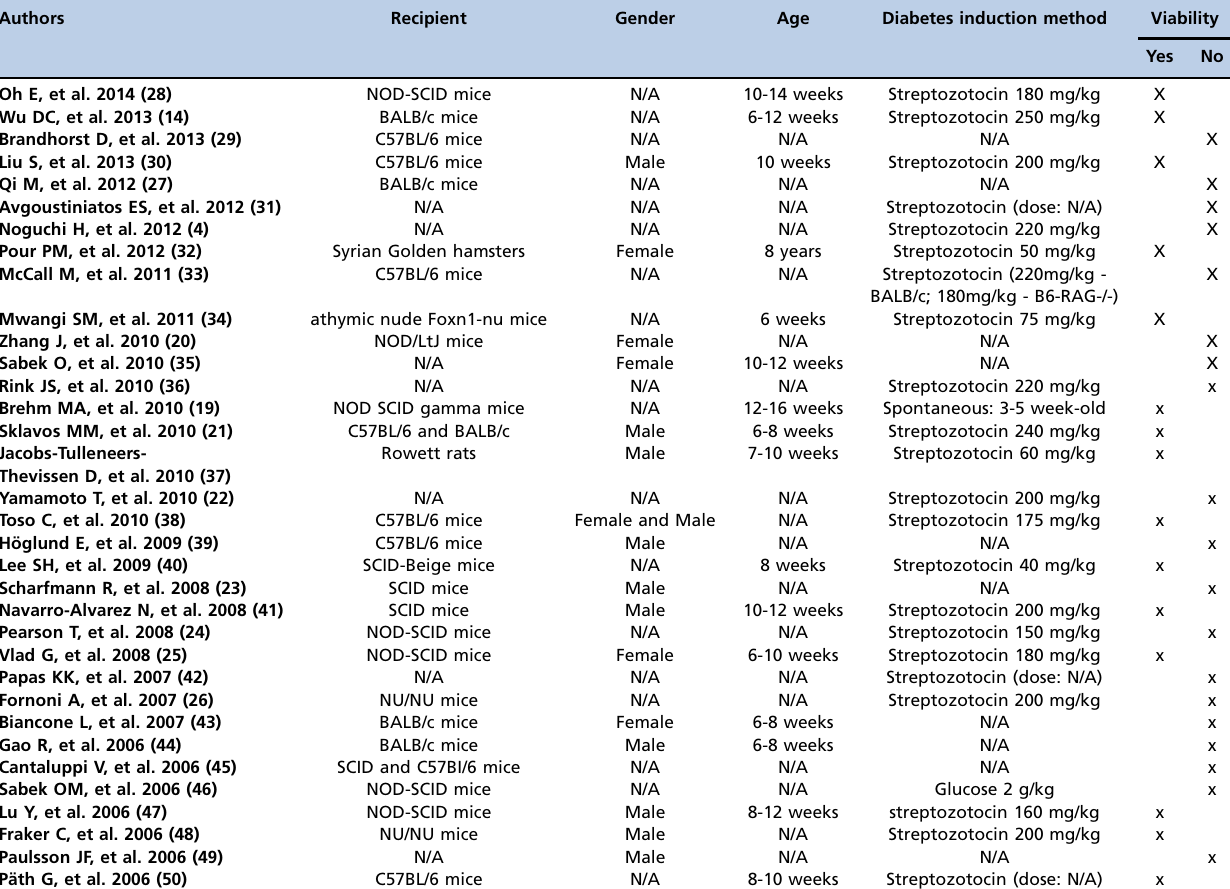
Table 1 - Comparative analysis of the types of rodents used and their clinical characteristics to evaluate the viability of the procedure: Strain, Gender, Age and Diabetes induction